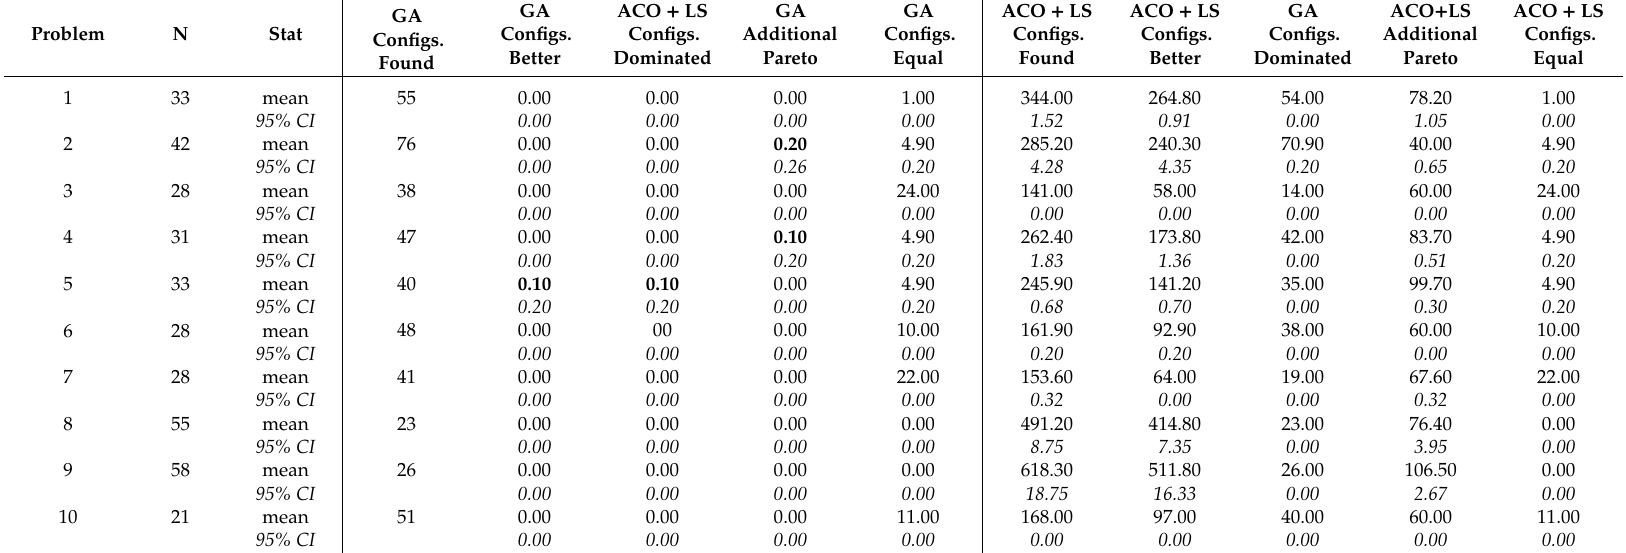
Table 3. Comparison of ACO + LS 60-min runs with GA Benchmark runs. Similarly to Table 2 but running each of the 10 runs for 1 hour. As in Table 2, statistical quantities are in italics indicate the 95% confidence interval (CI) of the estimate of the mean, while boldface is to indicate when GA has better or additional solutions than those found by ACO +